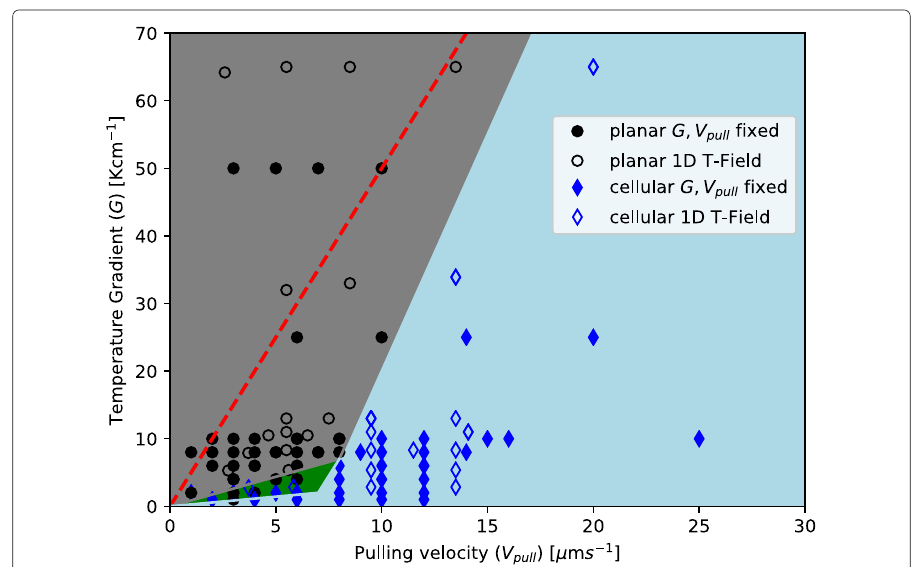
Fig. 19 Solidification front morphologies 400 s after start of solidification. The dashed red line indicates the constitutional undercooling criteria according to Eq. 1. The grey area indicates a morphologically stable planar front, the blue area of cellular growth morphologies and the green area the coexistence of cellular and planar